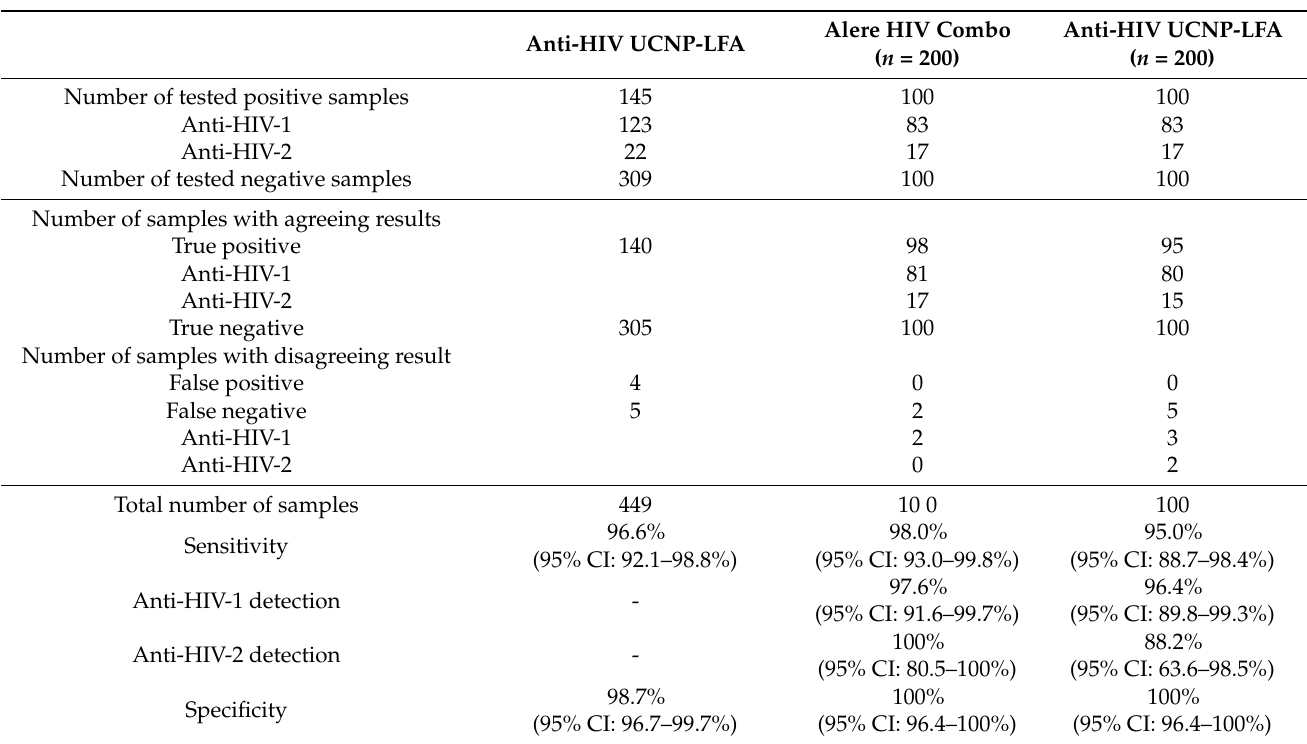
Table 3. Assay performances with clinical patient samples compared between the developed Anti-HIV-1/2 UCNP-LFA and Alere HIV Combo.